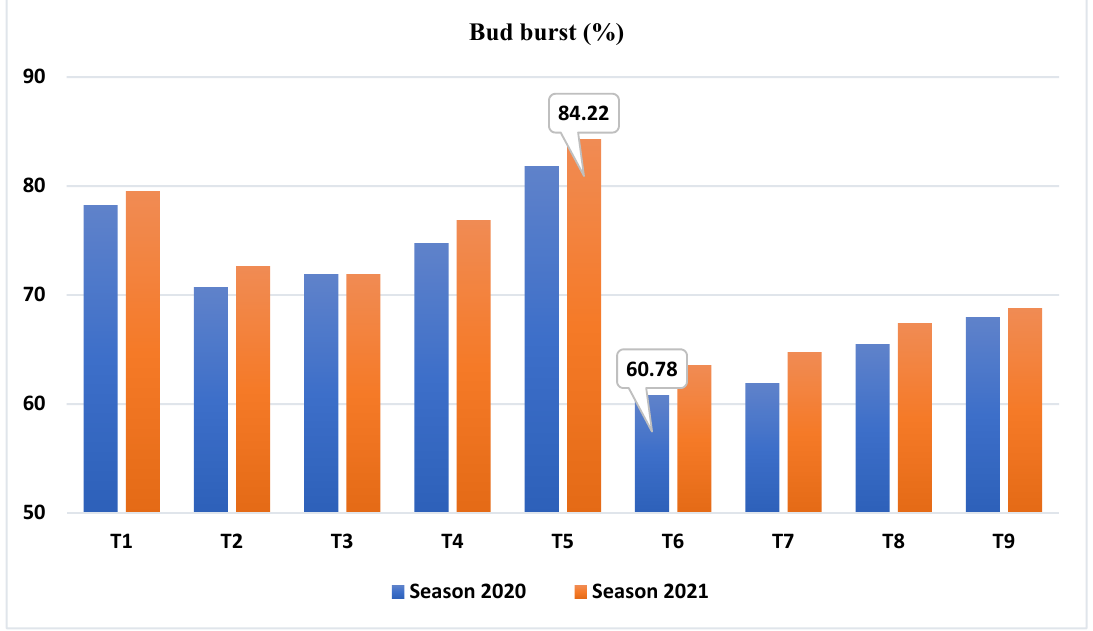
Figure 2. Effect of mineral fertilizer individual or combined with superabsorbent polymers (SAPs) on bud burst (%) of Autumn Royal grapevines in 2020 and 2021 seasons.